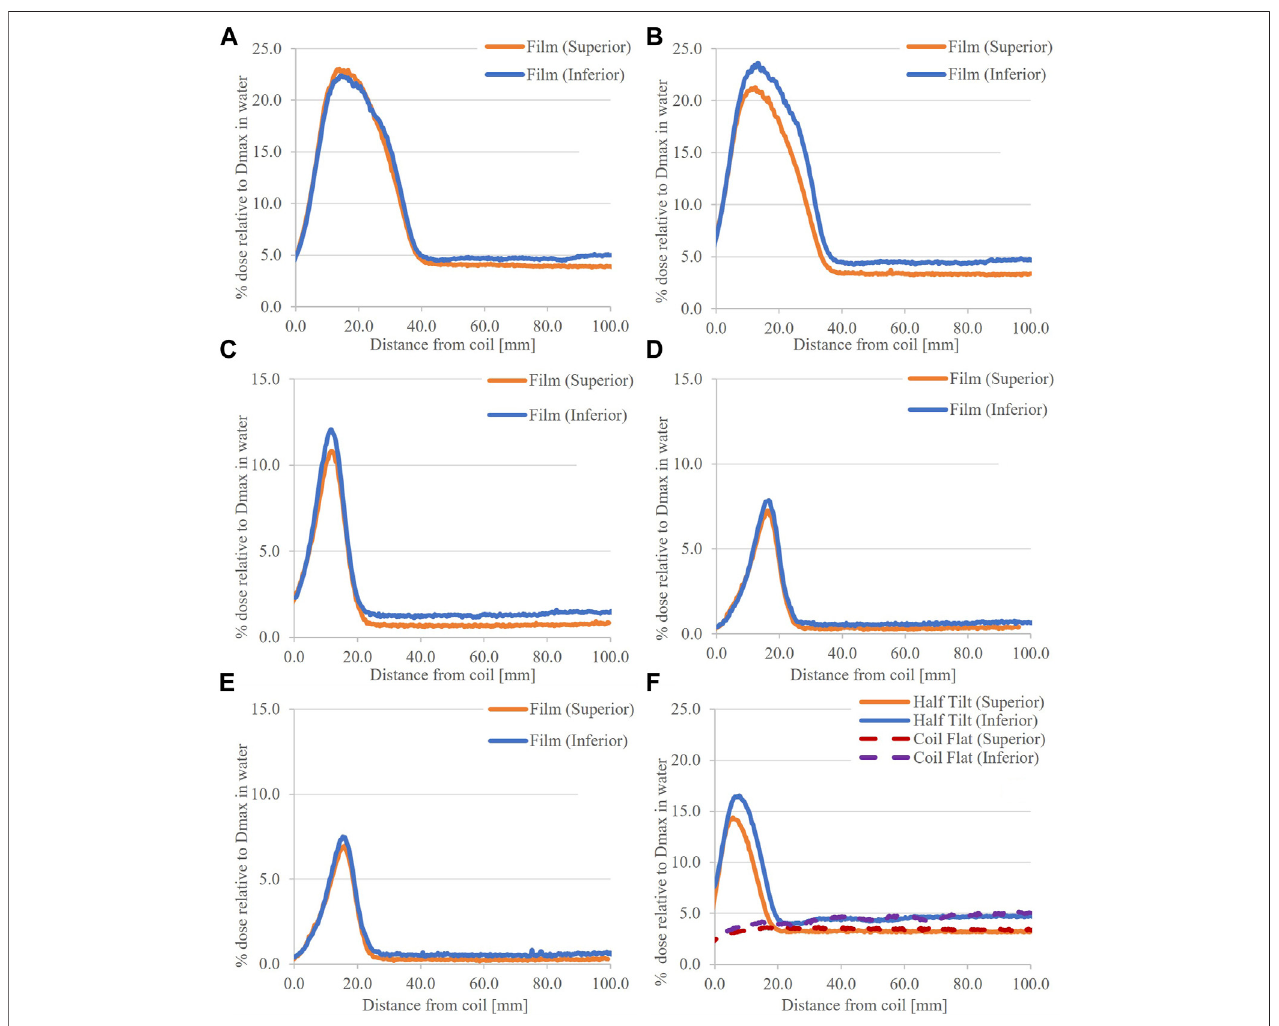
FIGURE 4 | Vertical pro fi les through measured ESE doses, coil tilted 7.0 ° , for the (A) 8.0 × 22.0 cm 2 , (B) 5.0 × 22.0 cm 2 , (C) 5.0 × 5.0 cm 2 , (D) 5.0 × 3.0 cm 2 , and (E) 3.0 × 3.0 cm 2 fi elds. In (F) doses for the coil tilted 3.5 ° and the coil fl at, using 5.0 × 22.0 cm 2 fi eld, are provided.